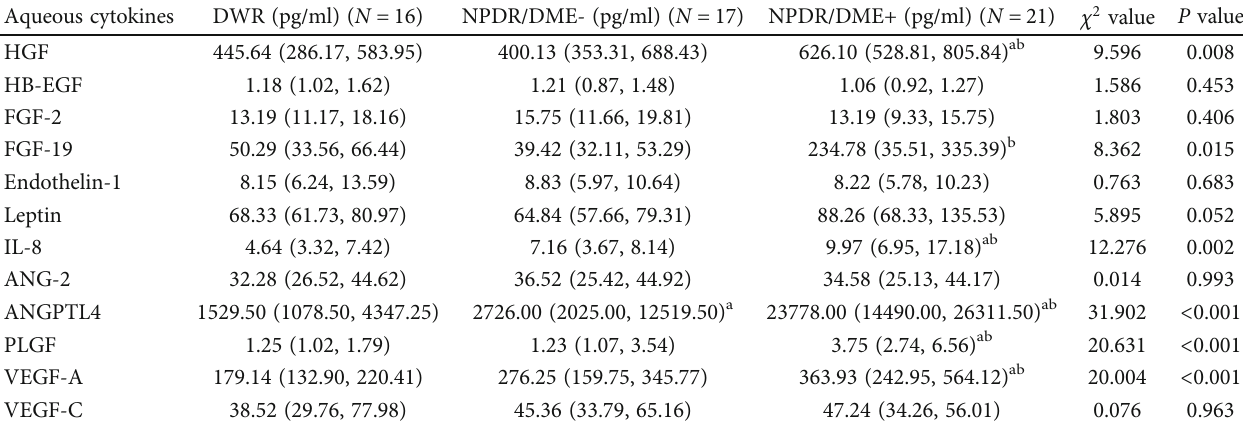
Table 2: Comparison of the cytokine levels in the aqueous humor among the 3 groups [M(Q1,Q3)]. Aqueous